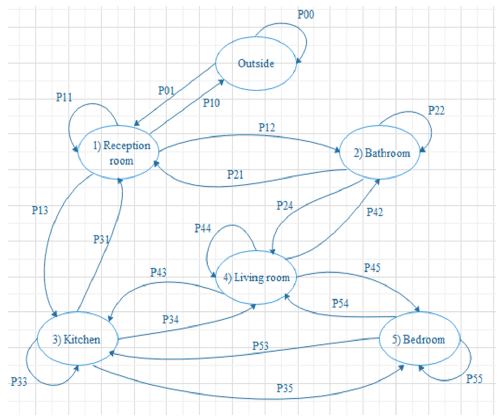
Figure 18. Transition states between